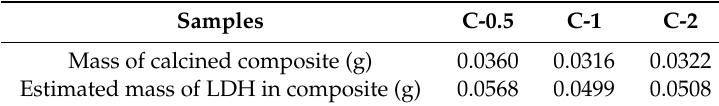
Table 1. Mass of each calcined composite and estimated mass of layered double hydroxide (LDH) in composite. Mass of the LDH was calculated taking into account that the Mg 2 Al(OH) 6 (CO 32 ´ ) 0.5 -LDH transformed into Mg 2 AlO 3.5 and that the agarose moiety was decomposed upon calcination.